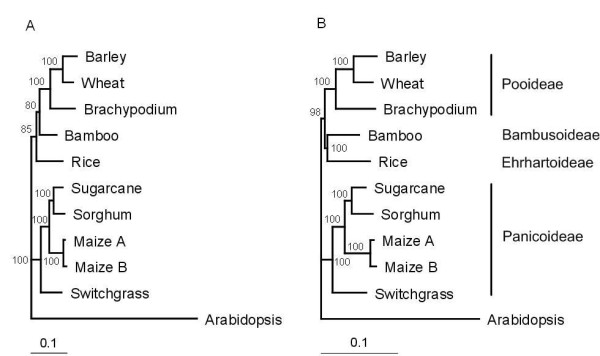
Phylogeny of grasses inferred from concatenated alignment of 43 putative orthologous cDNA sequences. (A) Tree inferred from maximal likelihood method. Bayes inference yielded the same topology. (B) Tree inferred from neighbor joining method. Branch length is proportional to estimated sequence divergence measured by scale bars. Numbers associated with branches are bootstrap percentages. Arabidopsis was used as outgroup. Subfamily affiliation of the grasses is indicated at right.